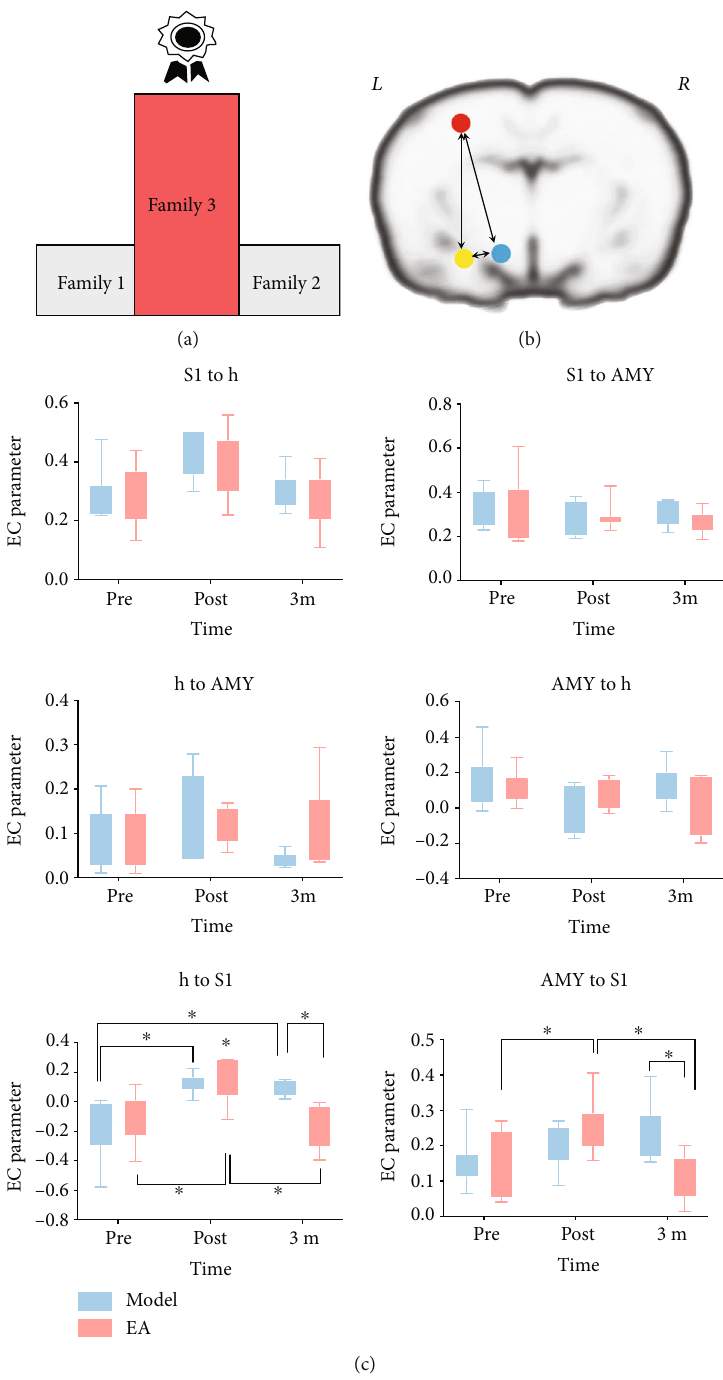
Figure 6: Group e ff ective coupling di ff erences of postulated cortically driven limbic network. (a) Schematic representation of the result of the winning family. (b) Schematic representation of interacting pain matrices. The red sphere represents the somatosensory cortex, the yellow one is the amygdala, and the blue one means the hypothalamus. (c) Results of group analysis of the e ff ective connectivity between the model and EA groups. Each mini-graph represents the result of each connection in the winning model (i.e., h-S1, AMY-S1, S1-h, S1-AMY, h-AMY, and